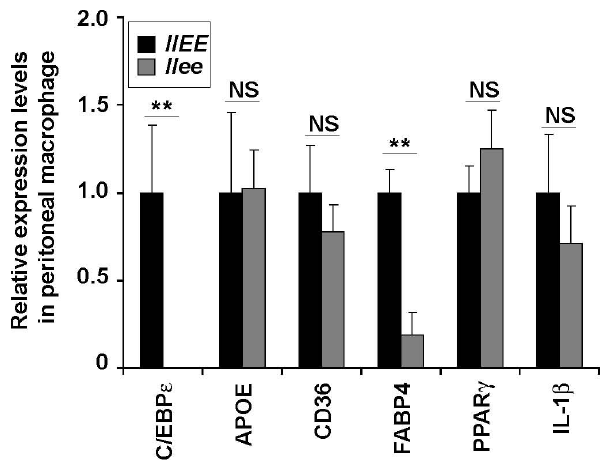
Figure 4. Altered gene expression in the peritoneal macro- phages from male Ldlr 2 / 2 /Cebpe 2 / 2 ( llee ) mice on a HCD. Peritoneal macrophages were isolated from male mice fed with HCD for 12 weeks. Gene expression levels of C/EBP e , APOE, CD36, FABP4, PPAR c , and IL-1 b were determined by qRT-PCR (n=4). Means and SD are shown. ** P , 0.01.